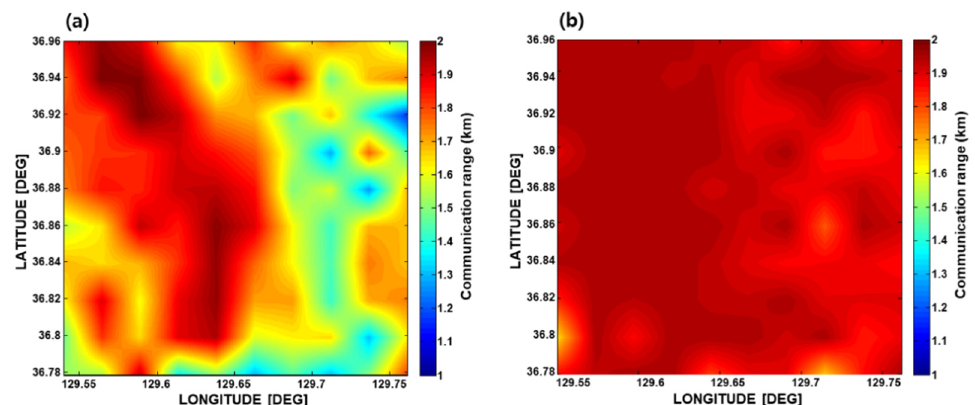
Figure 5. Communication PS simulated for the targeted area simulated for ( a ) the three-channel pressure sensor array, and ( b ) the single-vector sensor in the targeted area in February.